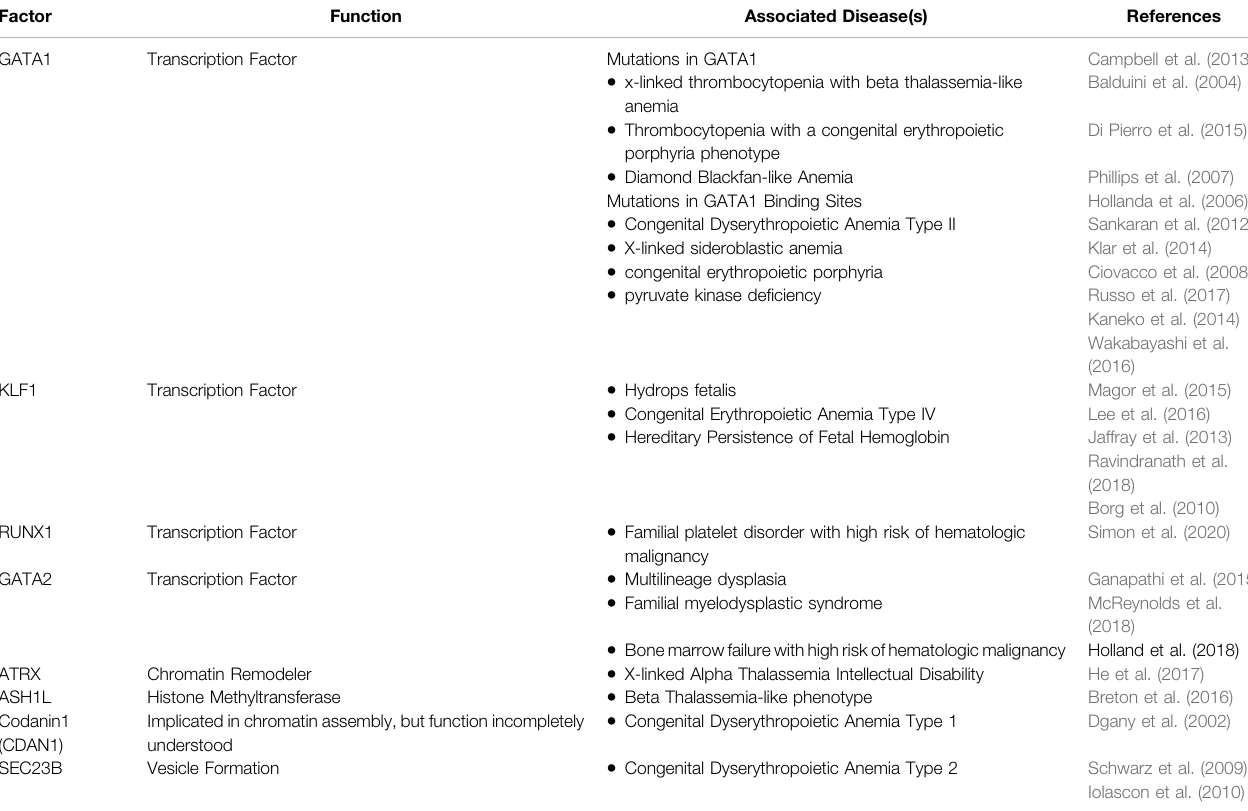
TABLE 1 | Transcriptional and epigenetic regulators associated with inherited